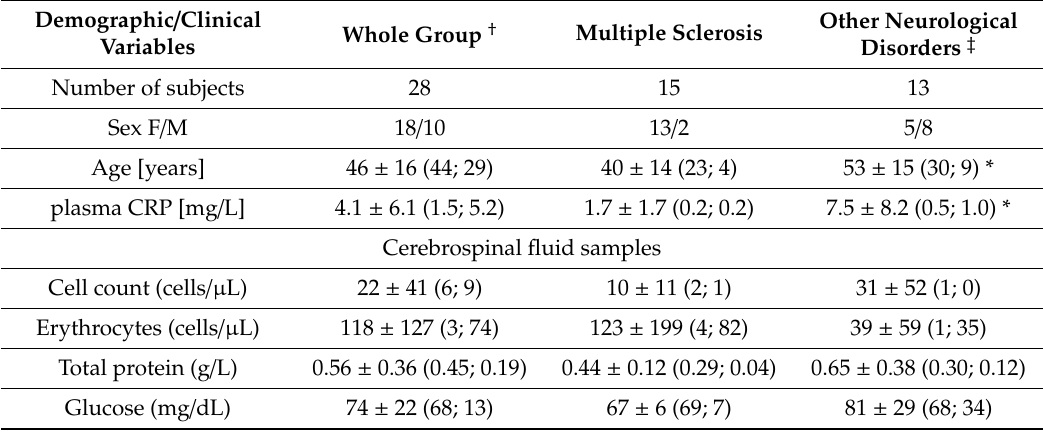
Table 1. Basic characteristic of studied patients with neurological disorders and samples of cerebrospinal